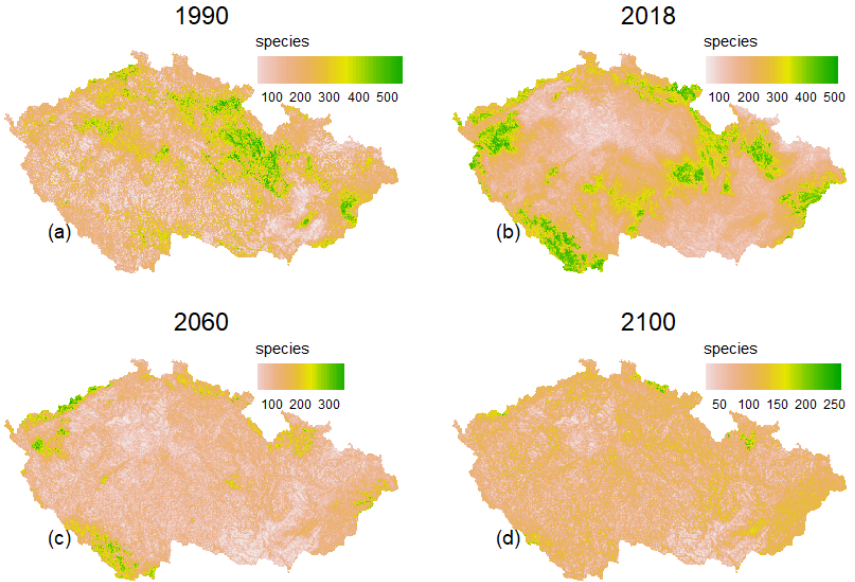
Figure 3. Spatial shifts in species richness: ( a ) baseline period (1990), ( b ) to the current pattern (2018) ( c ) near distant future (2060) and ( d ) far distant future (2100). Future changes are based on the (RCP 8.5) climate